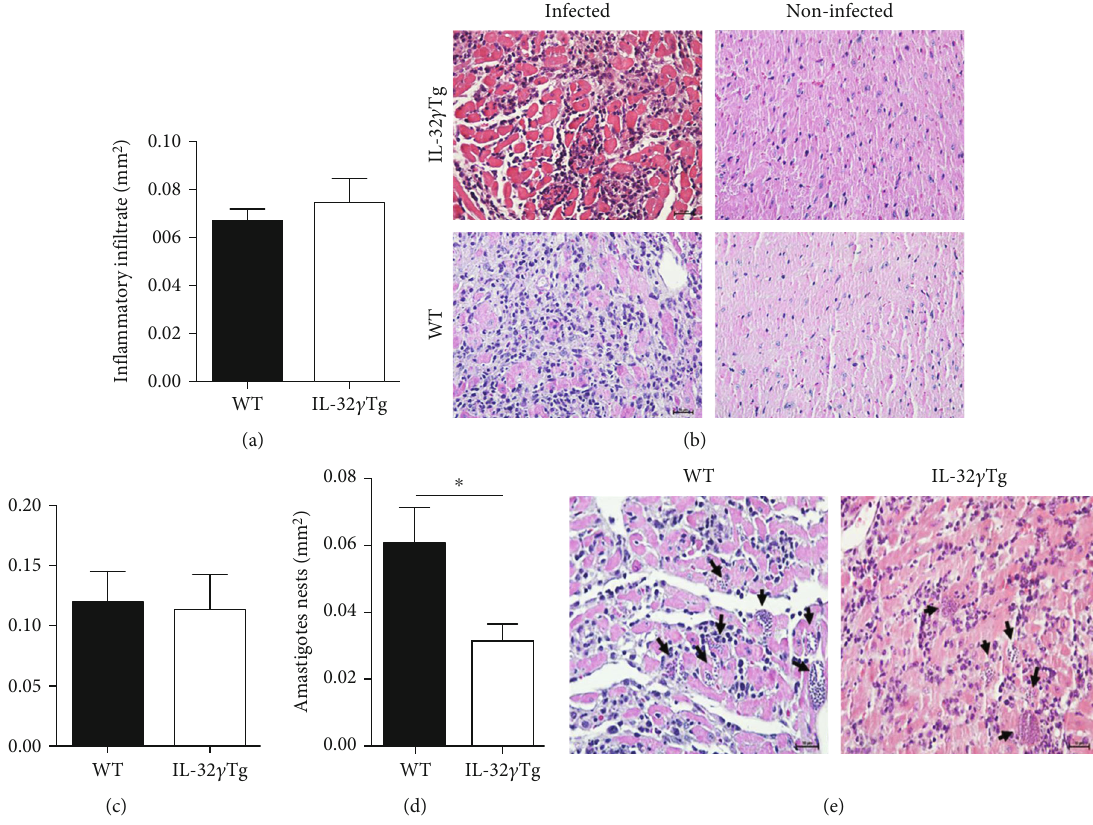
Figure 3: Morphological analysis of the heart of WT and IL-32 γ Tg mice noninfected or infected with the Colombian strain of T. cruzi in the acute phase of experimental Chagas disease. (a) Density of cardiac in fl ammatory in fi ltrate in infected WT and IL-32 γ Tg mice. (b) In fl ammatory in fi ltrate in the hearts of infected WT and IL-32 γ Tg mice (HE, 40x). (c) Percentage of collagen deposited in the heart. (d) Density and (e) histological sections of the amastigote nests in cardiac tissue of infected WT and IL-32 γ Tg mice (HE, 40x). ∗ p < 0 : 05 (Student ’ s t -test).